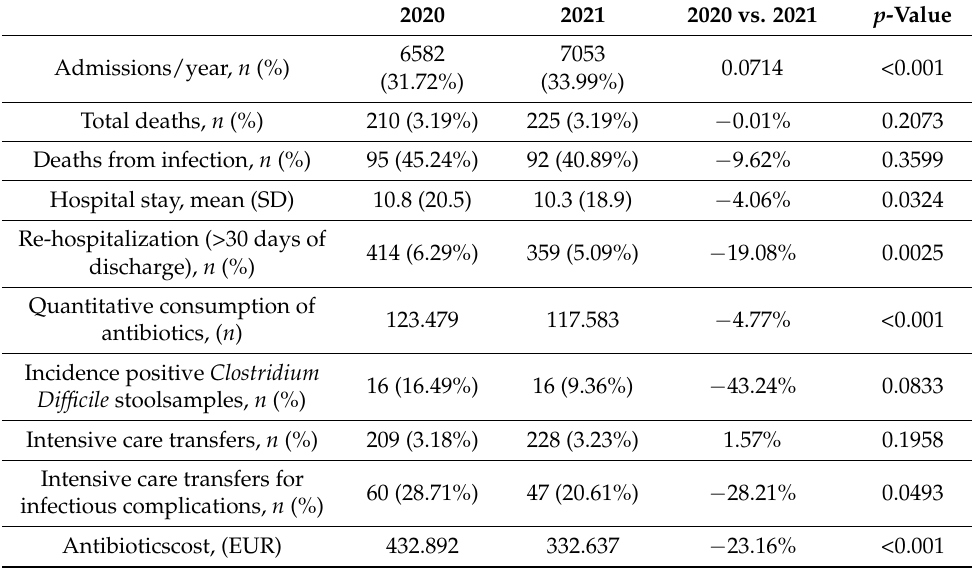
Table 4. The AMS program outcome measures and